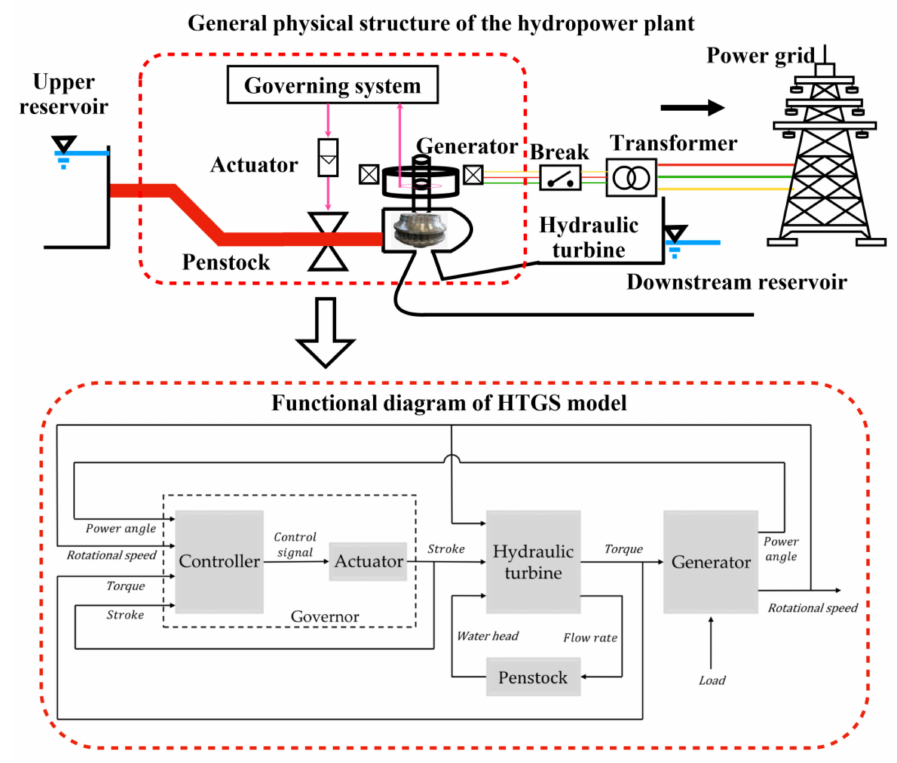
Figure 1. Structure of